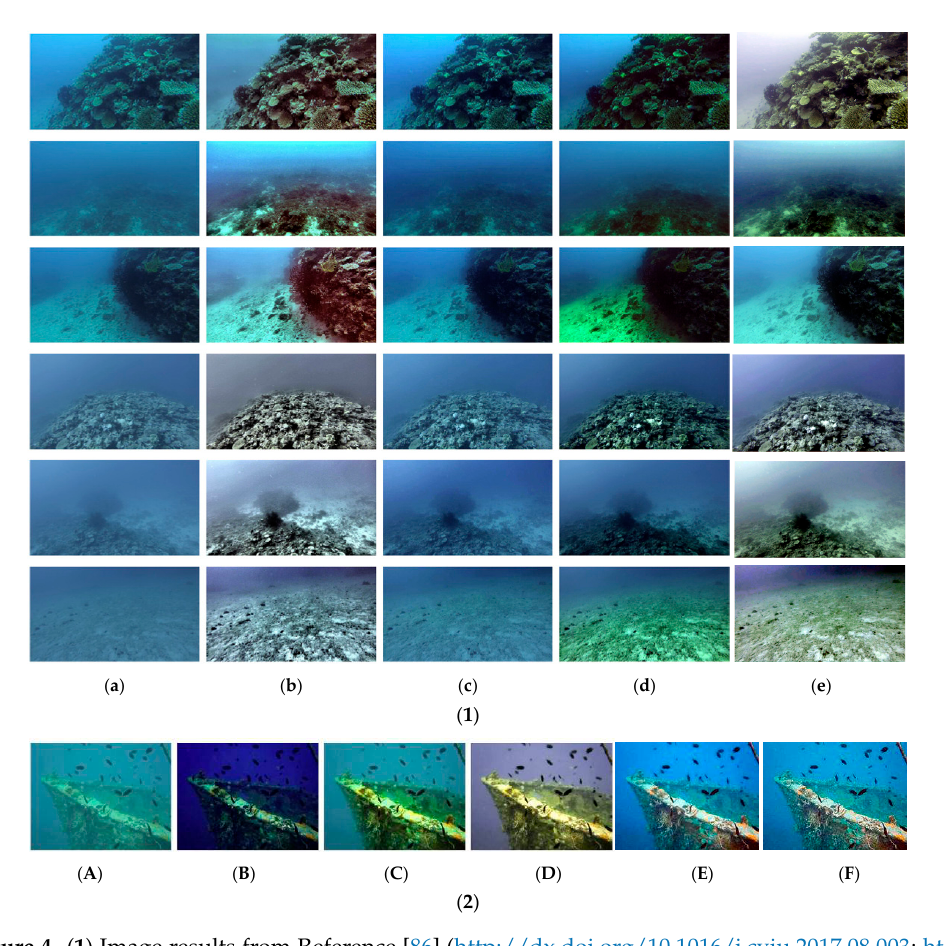
Figure 4. ( 1 ) Image results from Reference [86]